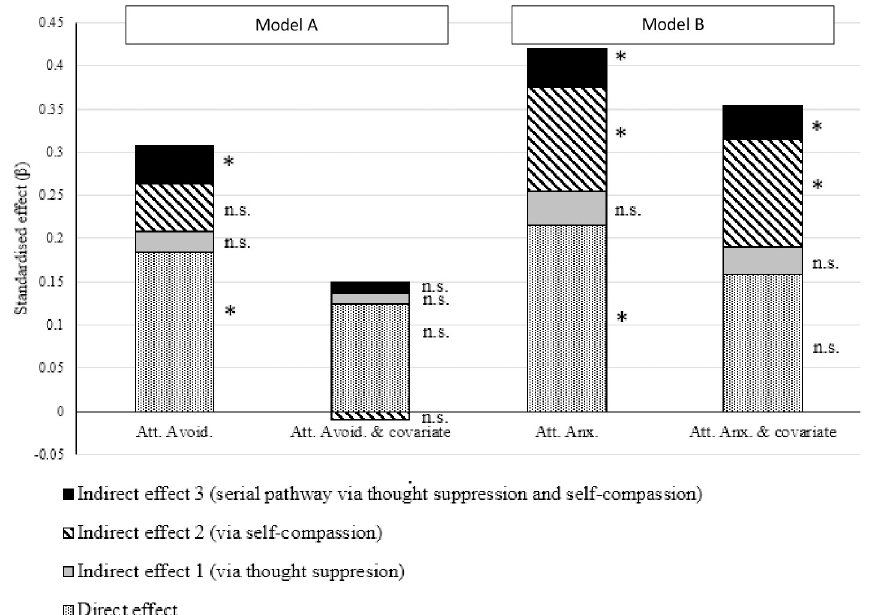
Fig 2. Effect sizes for Model A and Model B. Sizes of direct and indirect effects as indicated by standardized beta weights 03) for Model A (Att. Avoid., Att. Avoid & covariate) and Model B (Att. Anx., Att. Anx. & covariate) without and with the alternative attachment dimension as covariate. � —effect significant as indicated by 95% confidence interval not crossing zero. n.s.- effect non-significant as indicated by 95% confidence interval crossing zero.